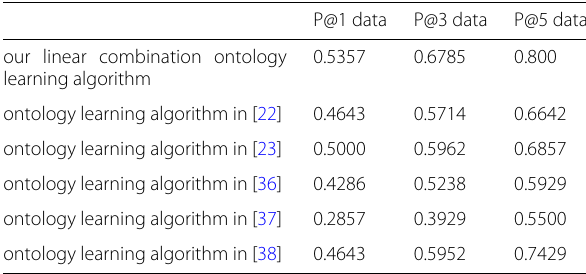
Table 1 Comparing result on university ontology when N = 1, 3,